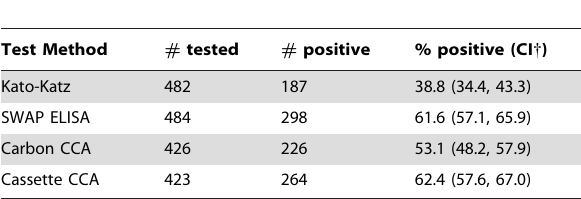
Table 1. Prevalence of S. mansoni according to each diagnostic method.